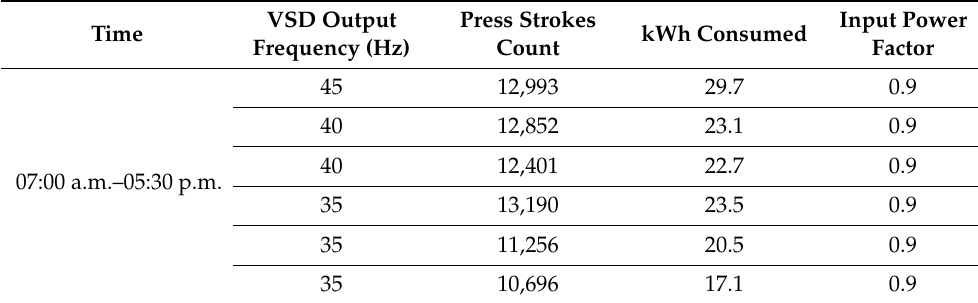
Table 4. Data collection was accomplished with an IIoT-based monitoring system with VSD control. VSD Output Press Strokes Input Power Time kWh Consumed Frequency (Hz) Count